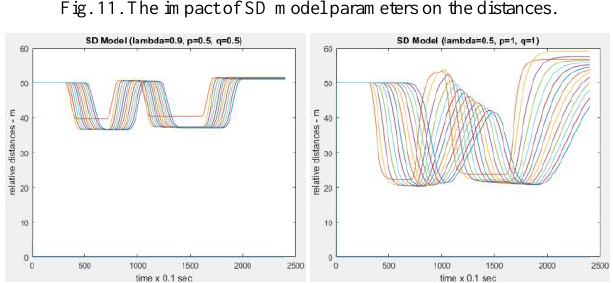
Fig. 11. The impact of SD model parameters on the distances.